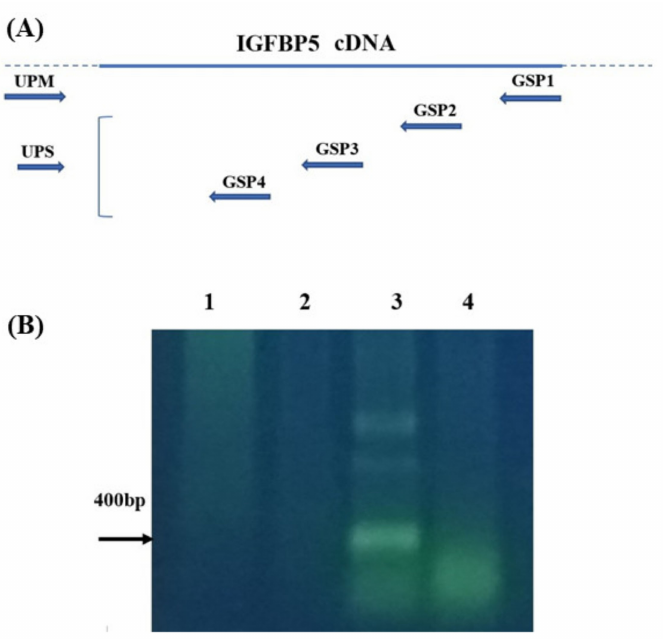
Figure 1. Acquiring the 5 (cid:48) -end sequence of goose IGFBP5 mRNA by 5 (cid:48) -RACE and the nested PCR with gene-specific primers. ( A ) A scheme showing the locations of gene specific primers (GSPs) over goose IGFBP5 cDNA sequence. ( B ) Gel image showing the electrophoresis-based separation of PCR products from 5 (cid:48) -RACE and the nested PCR with GSPs. Note: Lane 1 shows that the PCR products from 5 (cid:48) -RACE had no specific bands; Lanes 2 and 4 show that the products from the nested PCR with UPS and GSP2/3/4 primers using the 5 (cid:48) -RACE product; and Lane 3 shows a strong band of about 400 bp in size for the nested PCR with UPS and GSP3 primer, which was purified later for cloning and